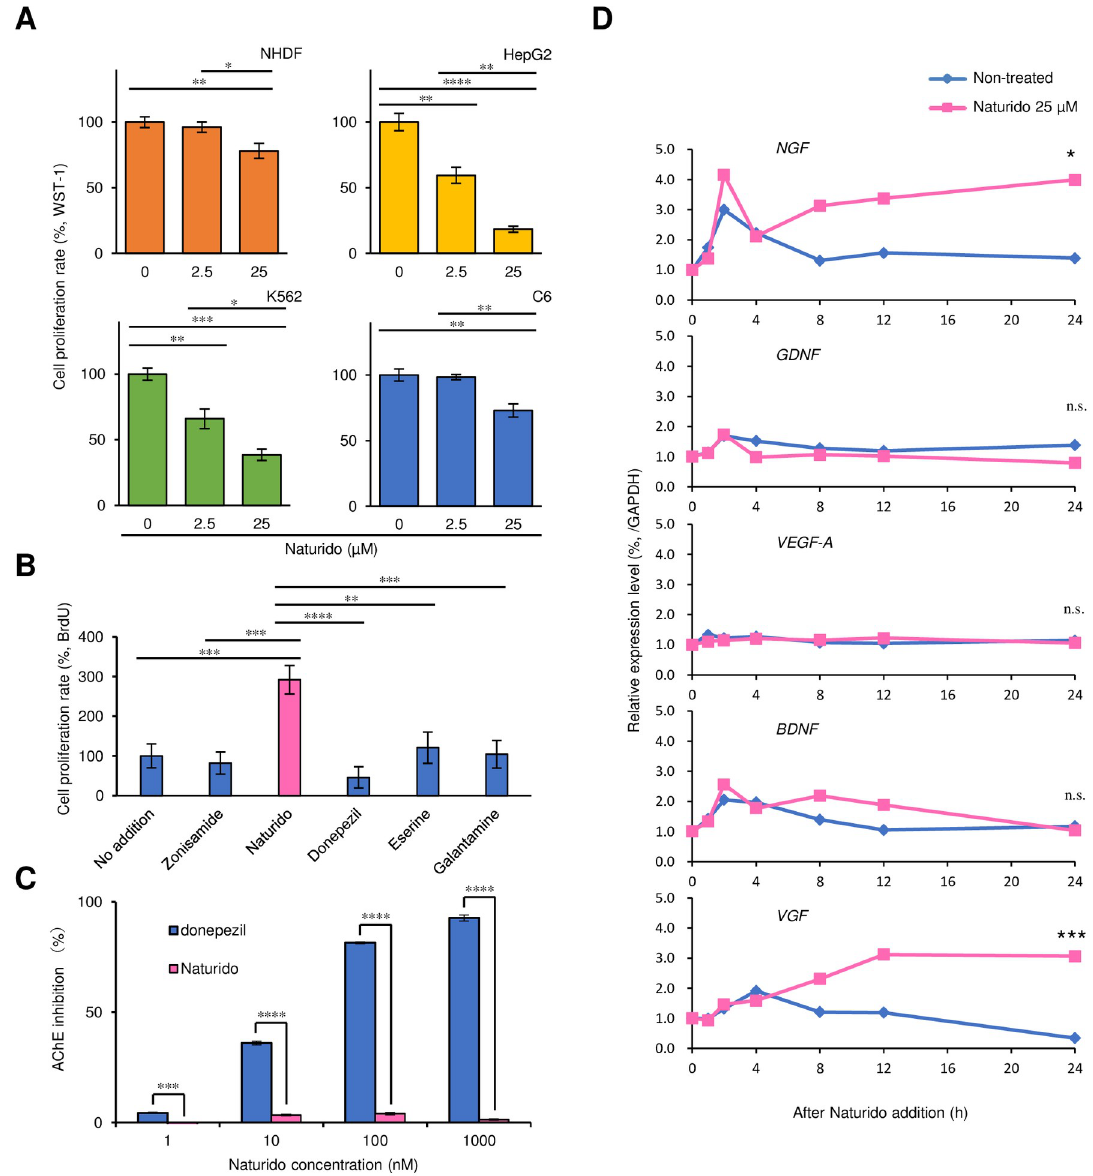
Fig 2. Relationship among Naturido and cell proliferation (A), therapeutic agents (B), acetylcholinesterase inhibitory activity (C), and the gene expression (D). (A) Normal human dermal fibroblasts (NHDFs), human hepatocellular carcinoma (HepG2) cells, human myeloid leukaemia (K562) cells and C6 glial tumour cells were used for proliferation assays with WST-1 (%) after treatment with Naturido at concentrations of 2.5 and 25 μ M. ( B) Each therapeutic agent (zonisamide, donepezil, eserine, and galantamine) was used at the same concentration as Naturido (25 μ M), and proliferation was measured with a BrdU assay (%). (C) Comparison of the inhibitory effects of Naturido and donepezil on acetylcholinesterase (AChE) activity, shown as AChE inhibition (%). (D) The mRNA expression levels of representative neurotrophic factors (nerve growth factor = NGF , brain-derived neurotrophic factor = BDNF , vascular endothelial growth factor = VEGF-A , glial cell line-derived neurotrophic factor = GDNF , and non-acronymic neuropeptide = VGF ) in astrocyte cultures were investigated to determine whether Naturido treatment enhances the expression of these genes. The Naturido concentration was 25 μ M. All values are expressed as means ± SEMs. � P < 0.05, �� P < 0.01, ��� P < 0.001, ���� P < 0.0001 vs each group (A-C Tukey-Kramer test using JMP 10.0.0) and vs the value at 24 h (D, t-test using JMP 10.0.0).